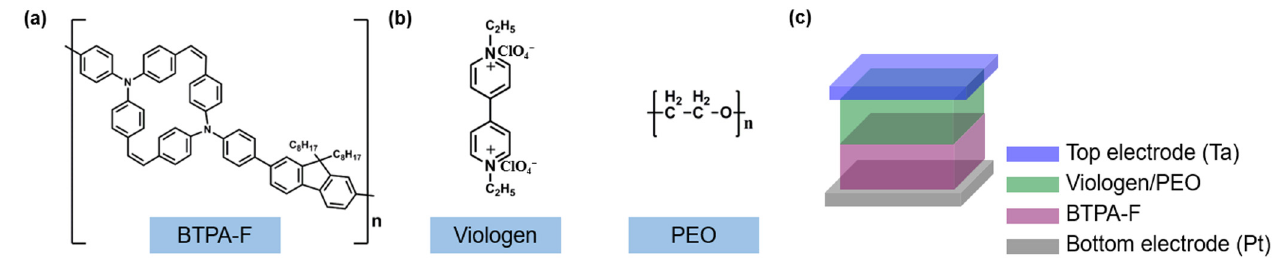
Figure 1. Device structure of the presented organic memristor. ( a , b ) The chemical structure of the BTPA-F and EV(ClO 4 ) 2 and PEO as anion acceptor, donor, and film-forming assistant, respectively. ( c ) Schematic illustration of the memristor device with Ta and Pt as the top and bottom electrodes, and the bilayer-structured EV(ClO 4 ) 2 /BFPA-F as the resistive switching layer.